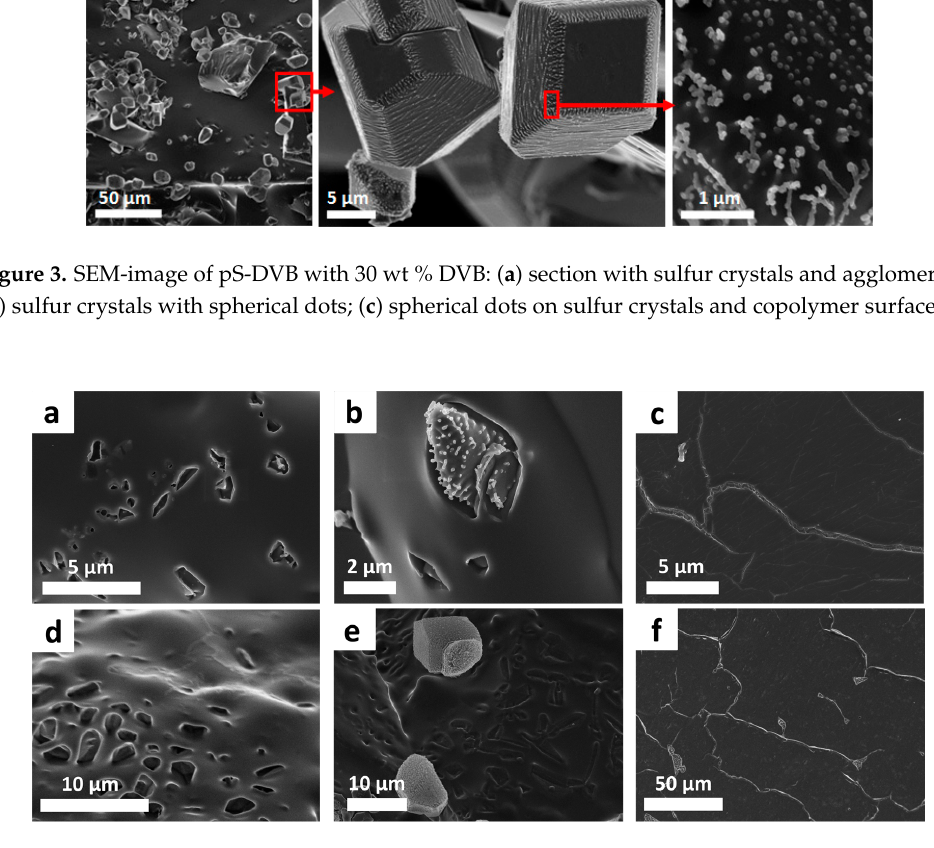
Figure 4. SEM-image of a crude sulfur copolymer with holes and plain surface ( a , d ); crude sulfur copolymer with sulfur crystals ( b,e ) and heated copolymer with cracks; treated with the hot press ( c , f ). Above pS-DVB is shown, and below pS-DIB is shown with 15 wt % vinyl